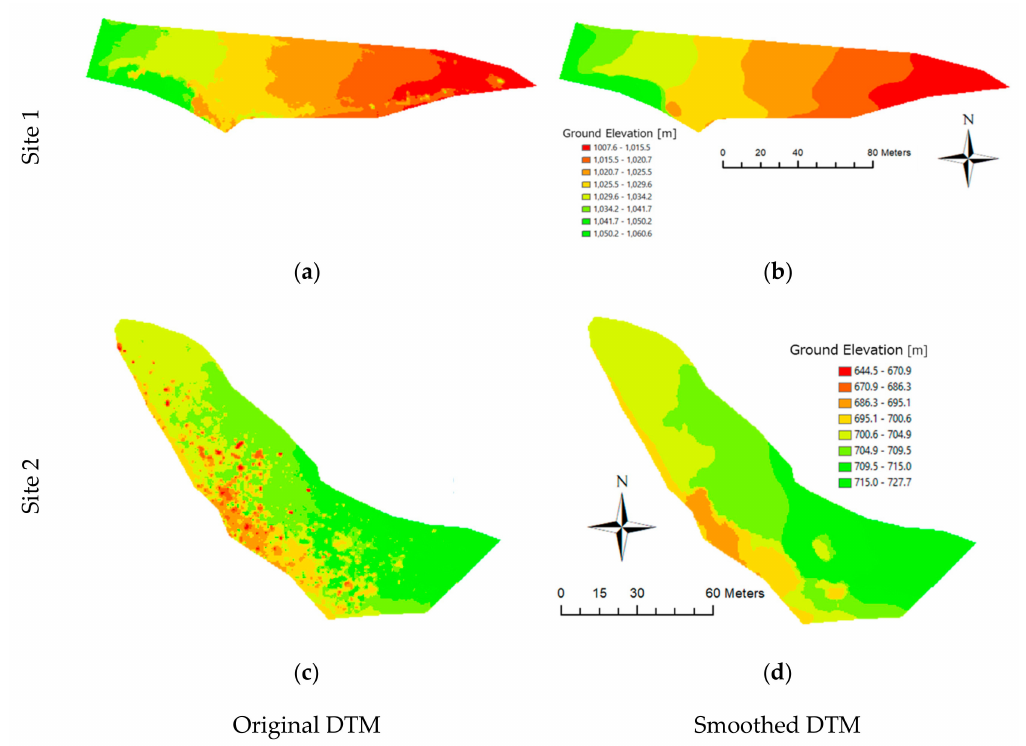
Figure 6. Original Digital Terrain Models (DTM) ( a , c ) and smoothed DTMs ( b , d ). Left and right column shows the result of Site 1 and Site 2, respectively. Red to green indicating ground